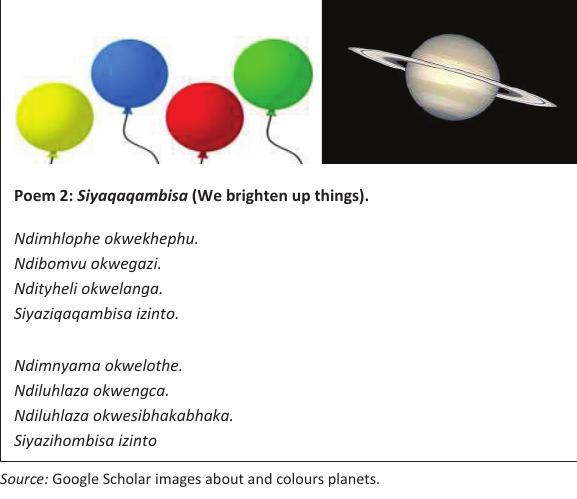
FIGURE 2: Different coloursed balloons are used to make the illustration fun because young children learn through play. The insertion of the planet also adds fun for young